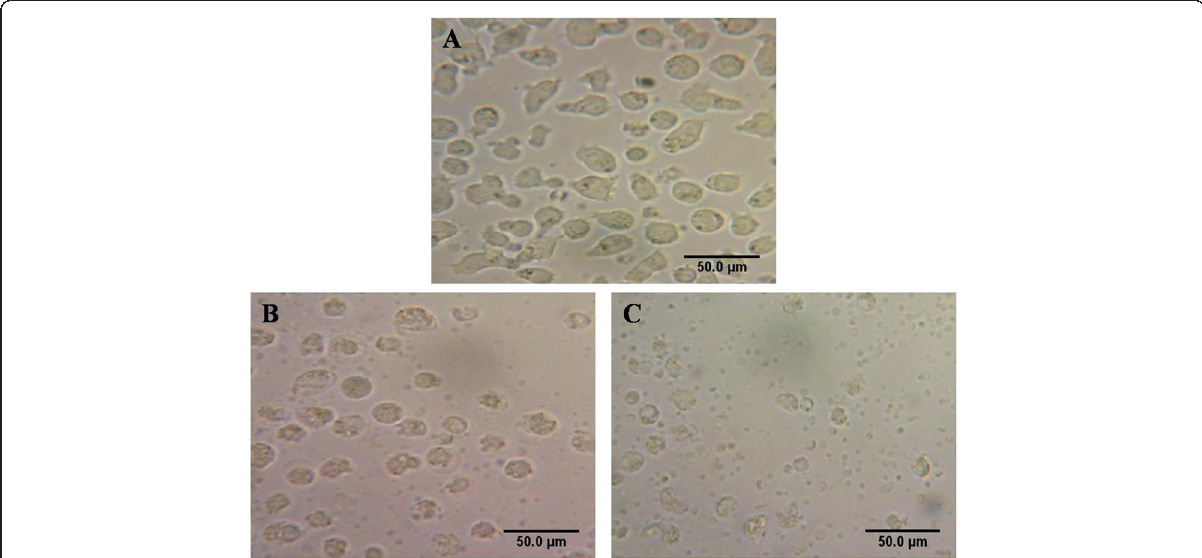
Figure 2 Effect of BV and BV/Pd (II) complex on the morphology of MOLT-4 cells. Photomicrographs from inverted microscope. Condensed nuclei obviously indicate apoptosis. (A) Controls, (B) cell treated with BV, (C) cells treated with BV/Pd (II) complex.